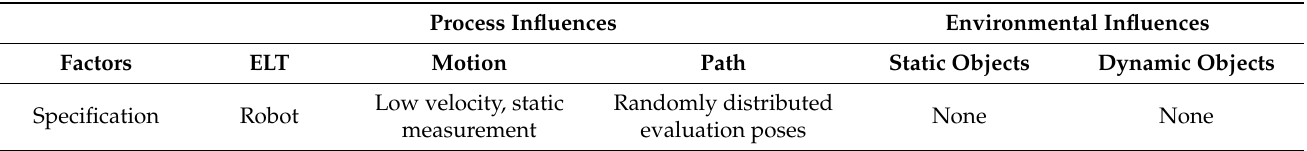
Table 3. Reference scenario for the T&E 4iLoc Framework .